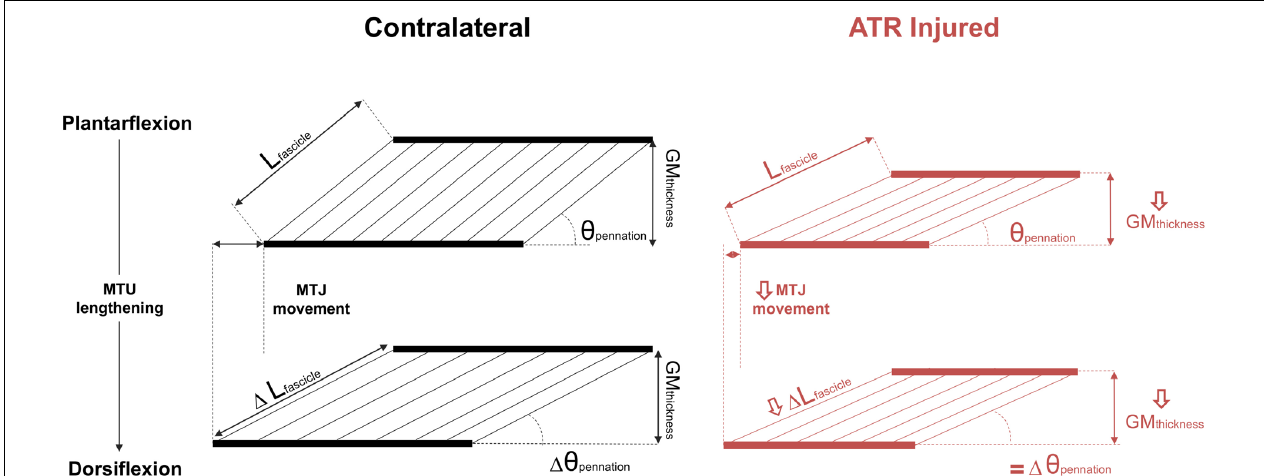
FIGURE 5 | A schematic summarizing the observed differences in MTU tissues when exposed to passive MTU lengthening between the contralateral (CON, left column, black) and ATR-injured tissues (right column, red) after surgical ATR repair. The top row depicts the two muscles as seen in plantarflexion, when the MTU is comparably slack, and the bottom row depicts the two muscles as seen in dorsiflexion, when the MTU is held in more tension. Absolute differences are indicated in the bottom row with (cid:49) ahead of the parameter, as the difference between plantarflexion and dorsiflexion. The top left diagram depicts the parameters of interest on the contralateral side: L fascicle is the measured length of the medial gastrocnemius fascicle, θ pennation denotes the pennation angle, GM thickness denotes the measured thickness of the medial gastrocnemius, and the distance between the dashed lines indicates the relative movement of the musculotendinous junction (MTJ). Arrows on the right column ATR parameters indicate significant differences to CON at the same position. Equal signs indicate no significant differences compared to